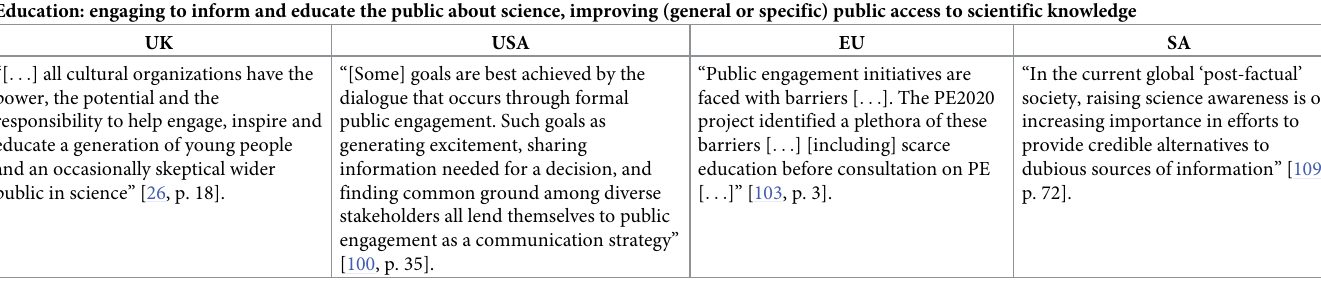
Table 5. Education as motivation for engagement in policy documents.